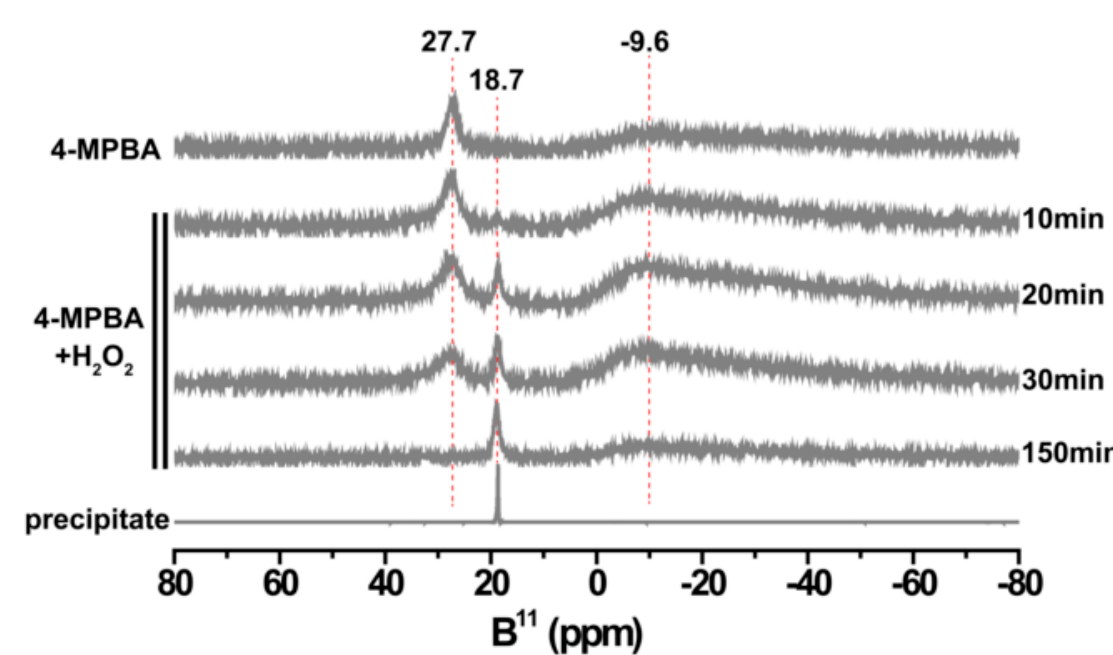
Figure 7. The 11 B NMR spectra for different samples. Top: 4 ‐ MPBA; middle: the change in the spectrum of the mixture of 4 ‐ MPBA and H 2 O 2 (0.15 M 4 ‐ MPBA, 0.94 M H 2 O 2 )with time; bottom: white precipitate formed during the reaction of 4 ‐ MPBA and H 2 O 2 .